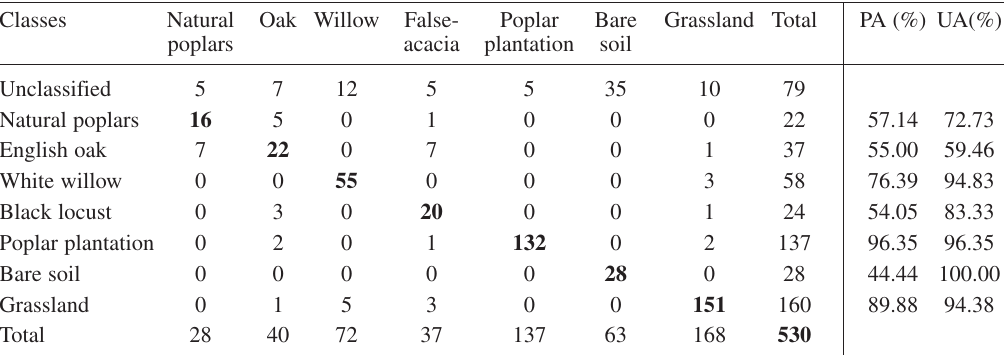
a b Fig. 4a,b. Remote sensing results: a) map of the forest species distribution obtained from automatic classifica- tion of DAIS hyperspectral images (grey tones correspond to not relevant areas, such as bare soil, water and rice fields); b) map of Leaf Area Index (LAI) for the natural forest and poplar plantation. LAI values are computed on the classes identified in the forest species map. Table II. Confusion matrix computed for the evaluation of classification accuracy. PA refers to producer accu- racy and UA to user accuracy. Classes